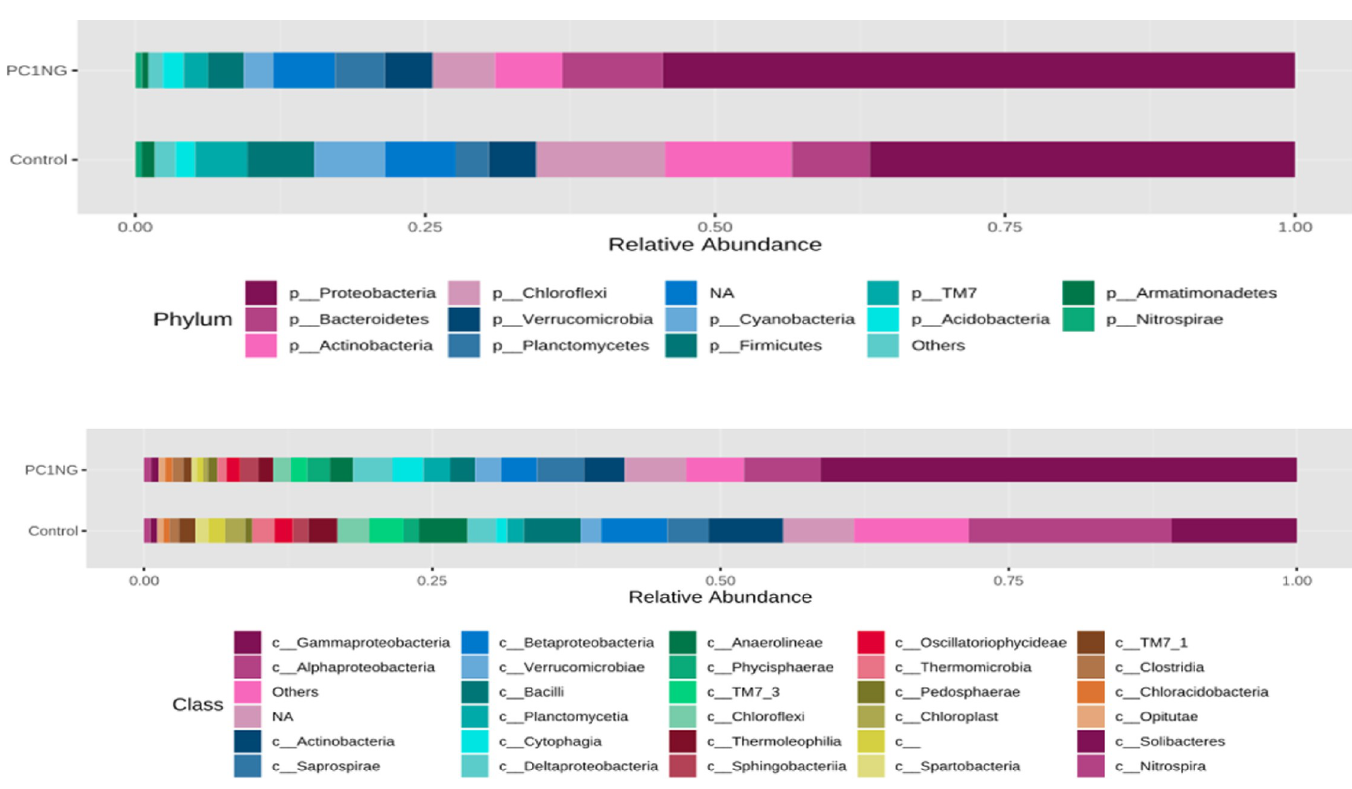
Fig 3. Stacked bar plots representing phylum and class distribution in control and treated soil